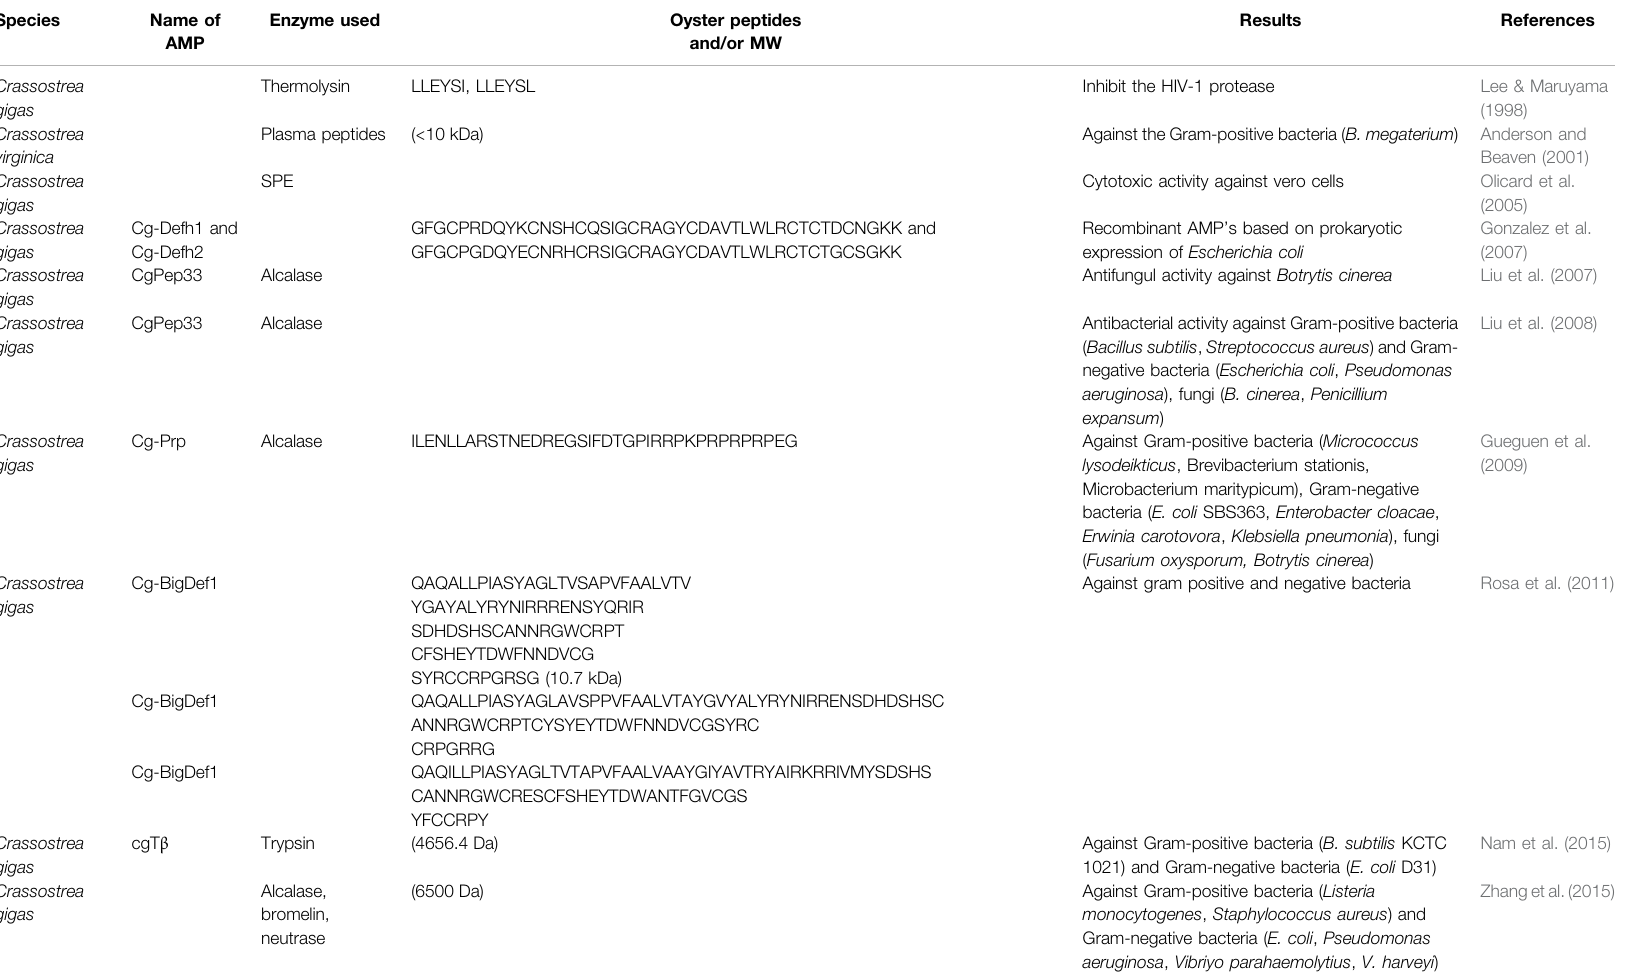
TABLE 3 | Antimicrobial peptide derived from oyster whole